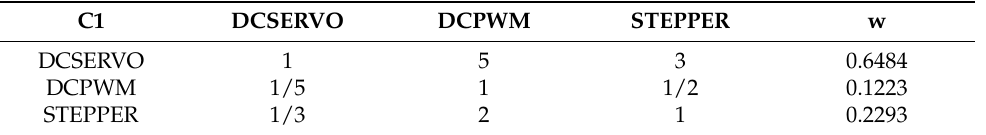
Table 4. Pairwise comparison of the actuation solutions (criterion